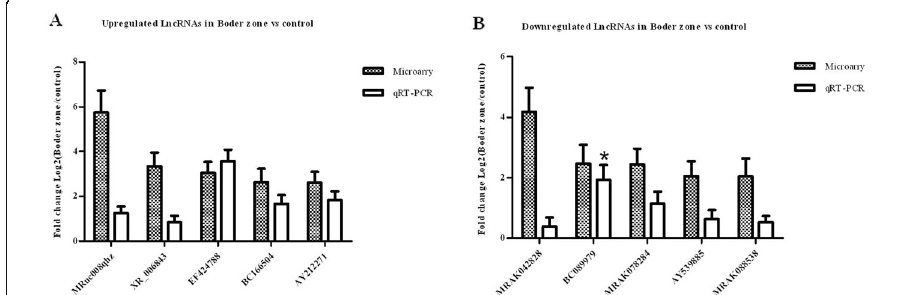
Fig. 7 a : Upregulated lncRNAs in border zone detected by qRT-PCR vs microarry; b : Downregulated lncRNAs in border zone detected by qRT-PCR vs microarry. The height of the columns indicate the log- transformed fold changes in the expression between the border zone and the control zone, and the bars represent standard errors. The shaded columns present the microarry expression of lncRNAs, while the blank columns present the qRT-PCR results. *Indicates that there is a disagreement between the microarray data and quantitative RT-PCR